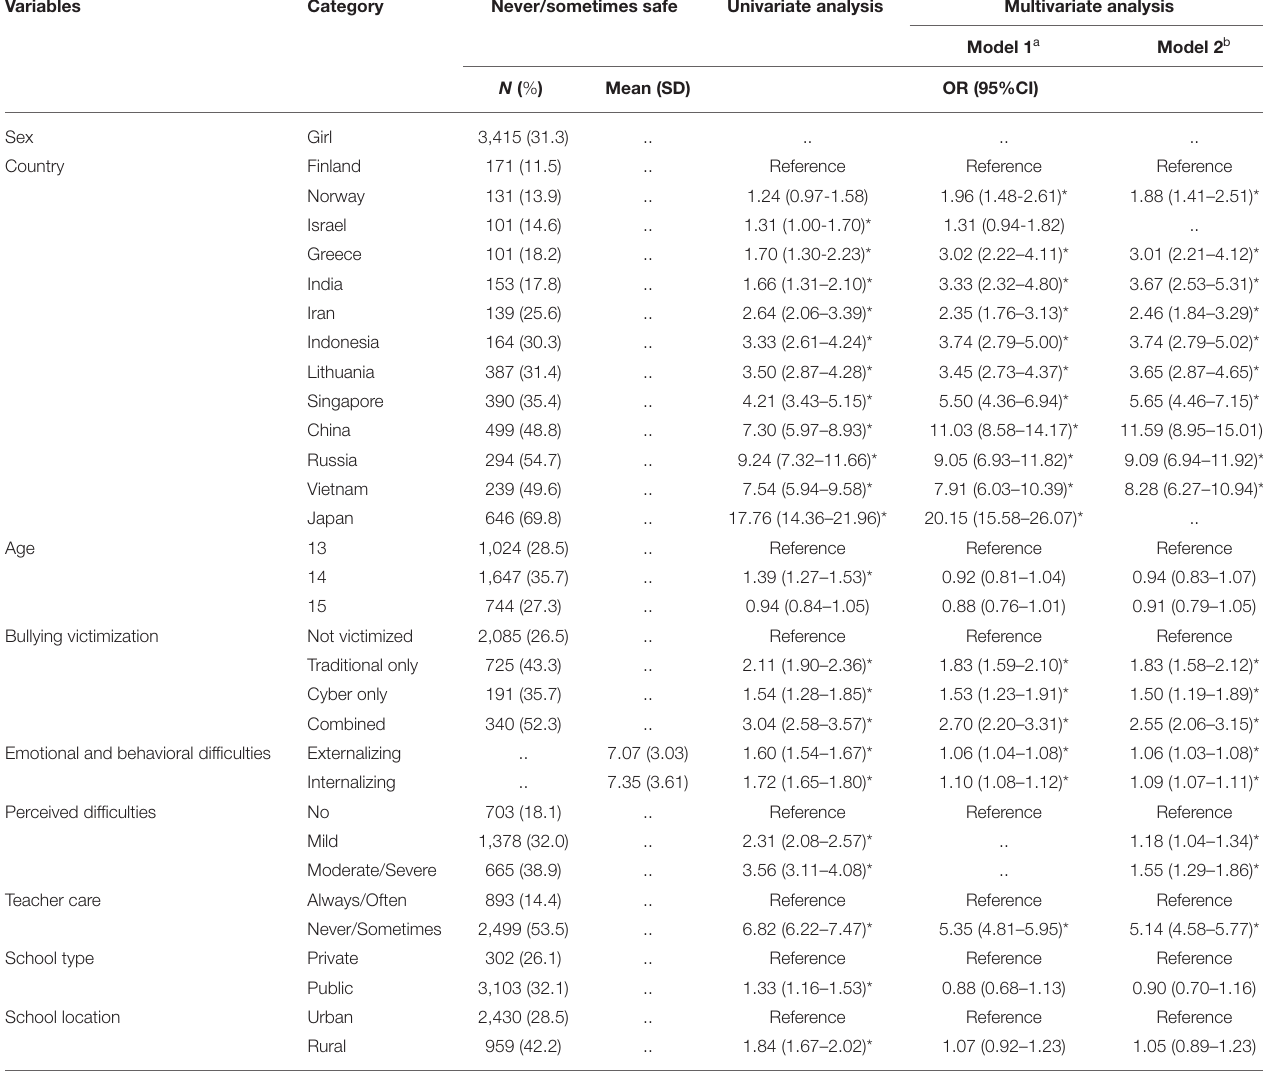
TABLE 3 | Univariate and multivariate analyses of the explanatory variables associated with feeling unsafe at school among girls.